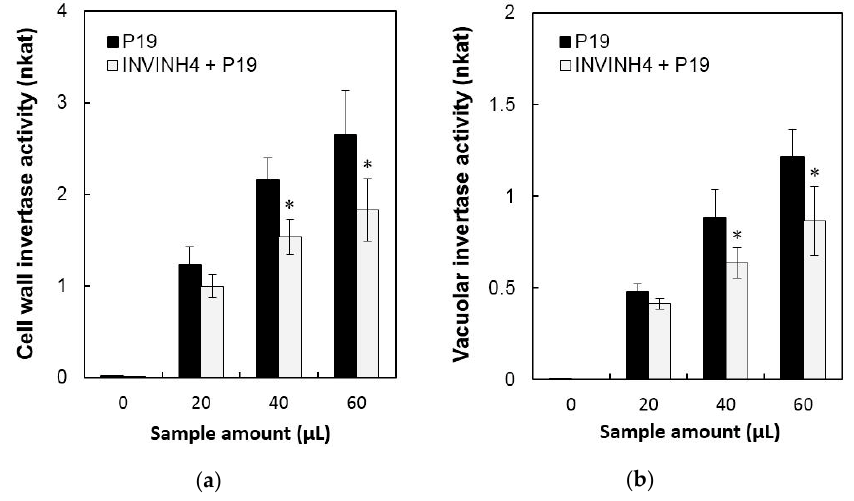
Figure 5. Transient expression assay of Zm-INVINH4 in potato leaves. ( a ) Effect on cell wall invertase activities. ( b ) Effect on vacuolar invertase activities. The enzyme activity data represent mean ± SE of at least four independent biological replicates and asterisks, indicating significant differences in comparison with the P19 by using a Student’s t -test: * p < 0.05.